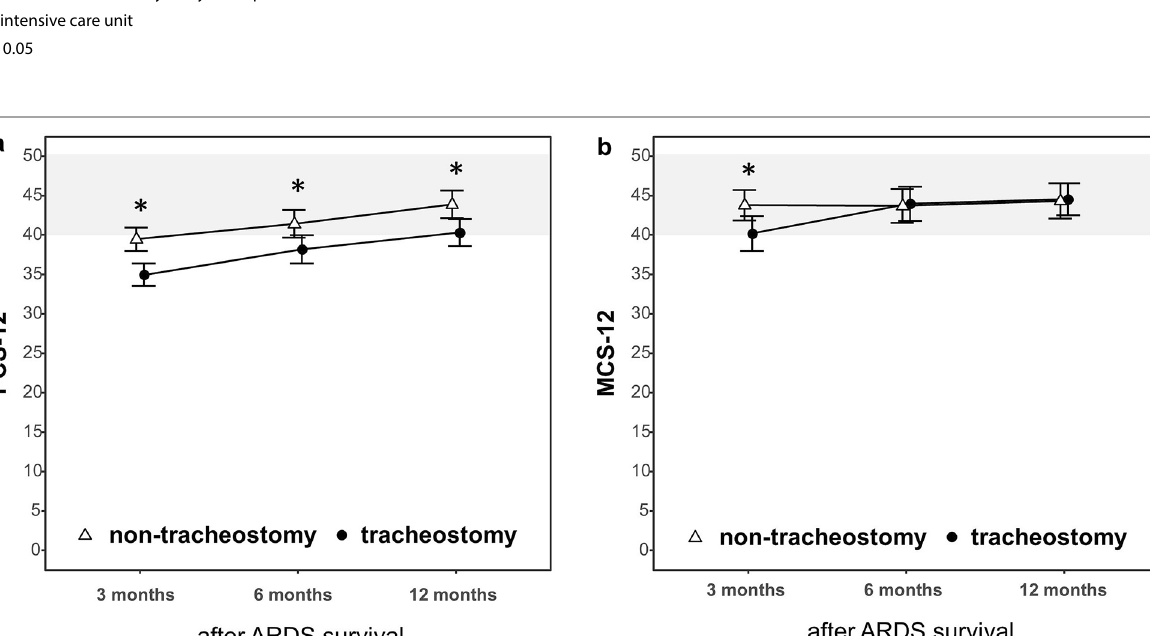
Return-to-work could only analysed in patients which worked before the critical illness